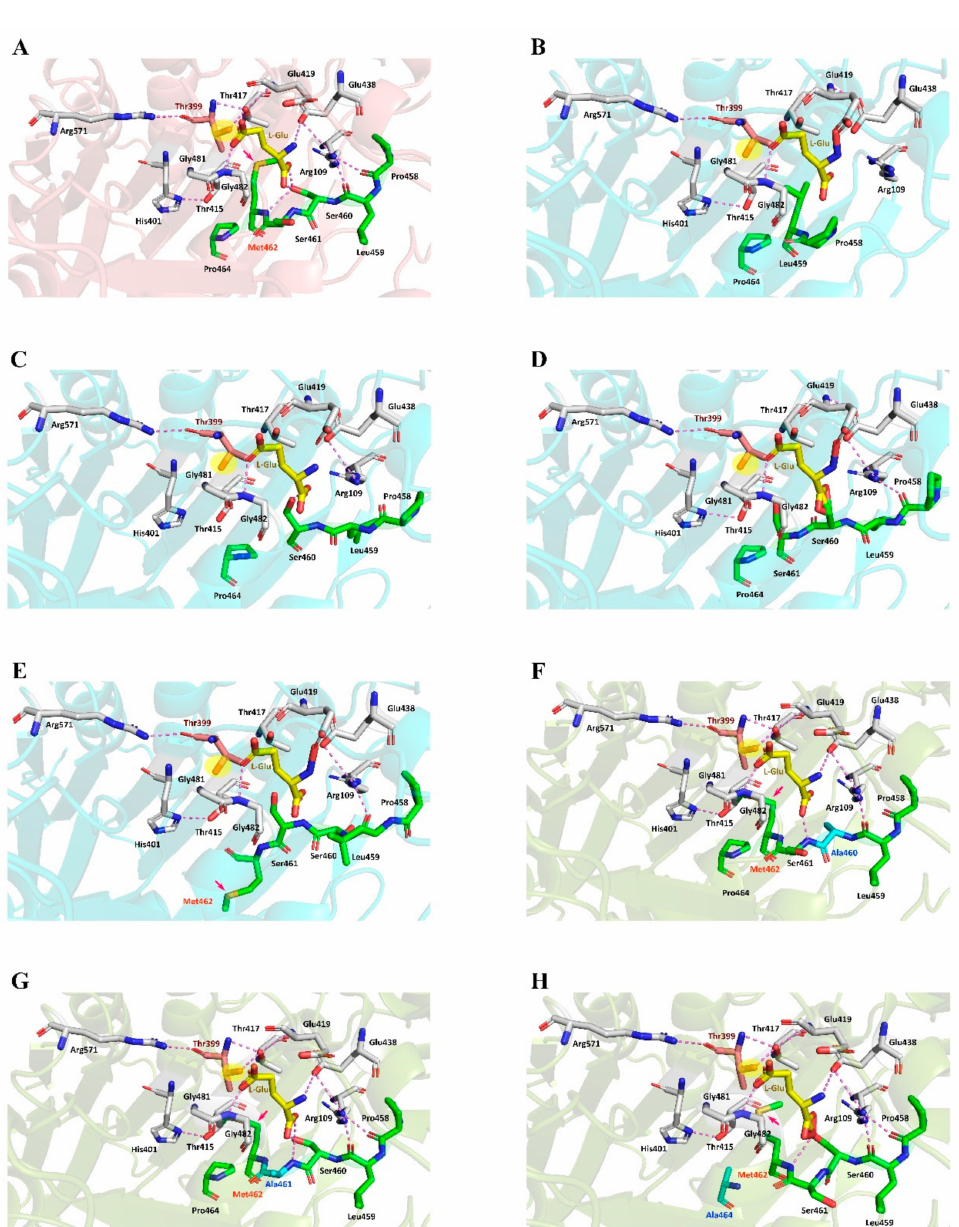
Figure 7. Comparison of the catalytic environments of wild-type and mutant enzymes. The catalytic environments were plotted by the program PyMOL (https: // pymol.org). Critical residues, including Arg109, Thr399, His401, Thr415, Thr417, Glu419, Glu438, Gly481, Gly482, and Arg571, are shown. The catalytic environments of wild-type and mutant enzymes were individually presented in panels ( A ) ( Bl GGT), ( B ) ( ∆ S460-M462), ( C ) ( ∆ S461-M462), ( D ) ( ∆ M462), ( E ) ( ∆ P464), ( F ) (S460A), ( G ) (S461A), and ( H ) (P464A). The carbon skeleton of the PLSSMXP sequence is highlighted in green and the hydrogen bonds are indicated by pink dashed lines. The side-chain hydroxyl group of the catalytic Thr399 is shaded in yellow and the side-chain position of Met462 is indicated by a pink